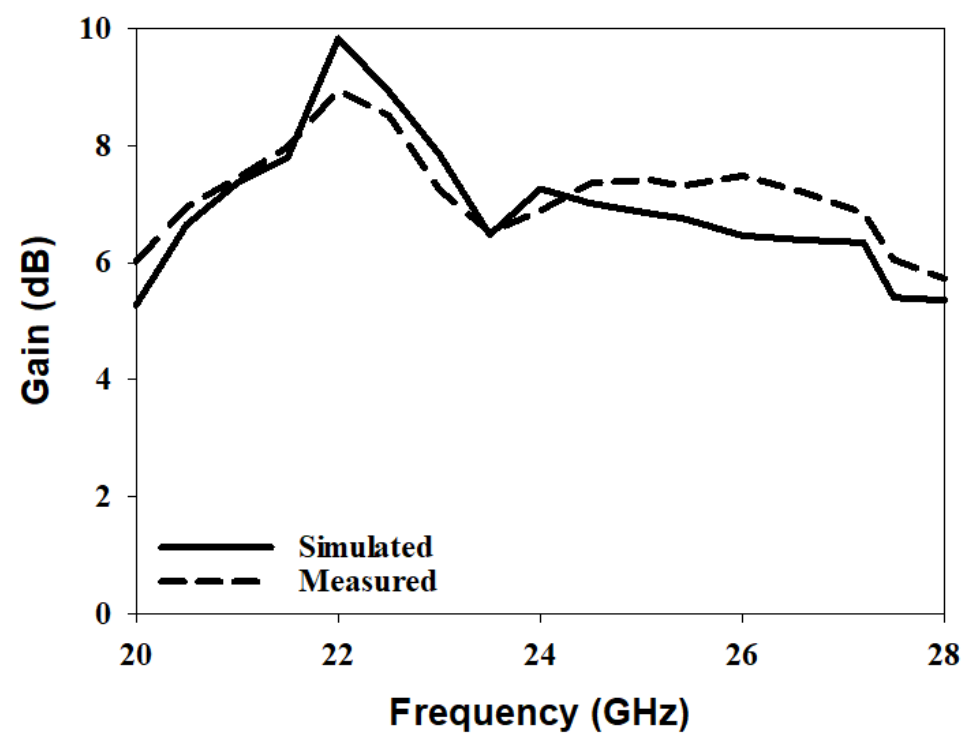
Figure 21. Broadside gain of a circularly polarised integrated hemispherical DRA and a perforated substrate.